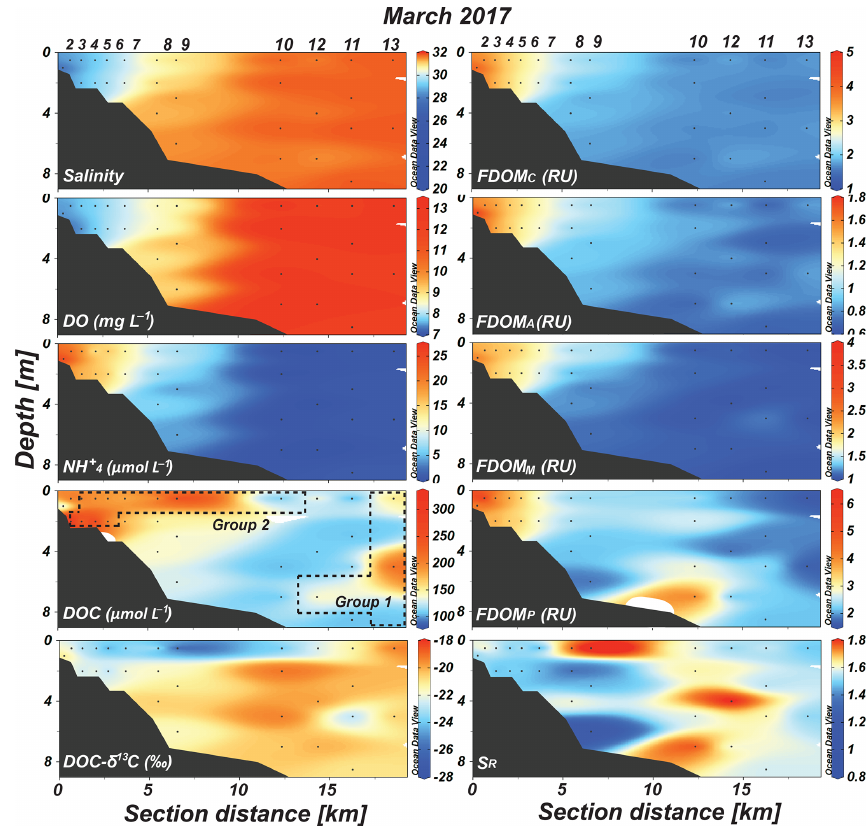
Figure 2. Vertical distributions of salinity, DO, NH + , DOC, DOC- δ 13 C, FDOM C , FDOM A , FDOM M , FDOM P , and S R values in Sihwa 4 Lake in March 2017. The dashed blocks represent stations belonging to Group 1 and Group 2, which were separated based on the distributions of DOC, DOC- δ 13 C, and